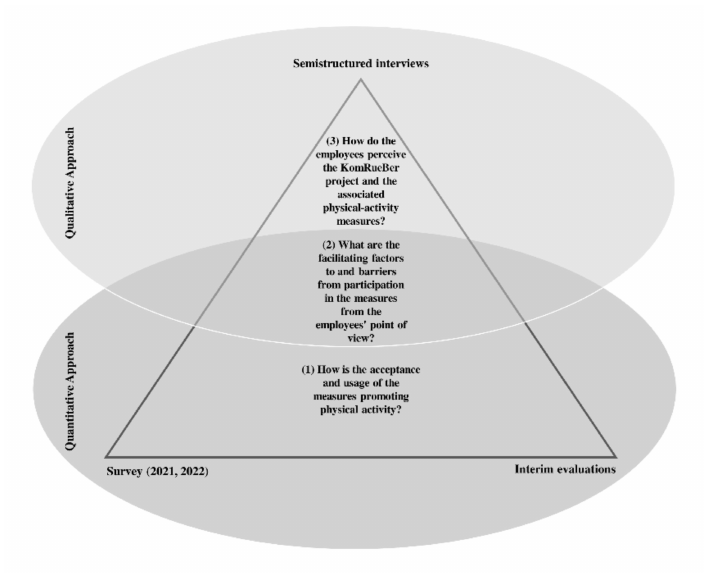
Figure 3. Triangulation of qualitative and quantitative data within KomRueBer